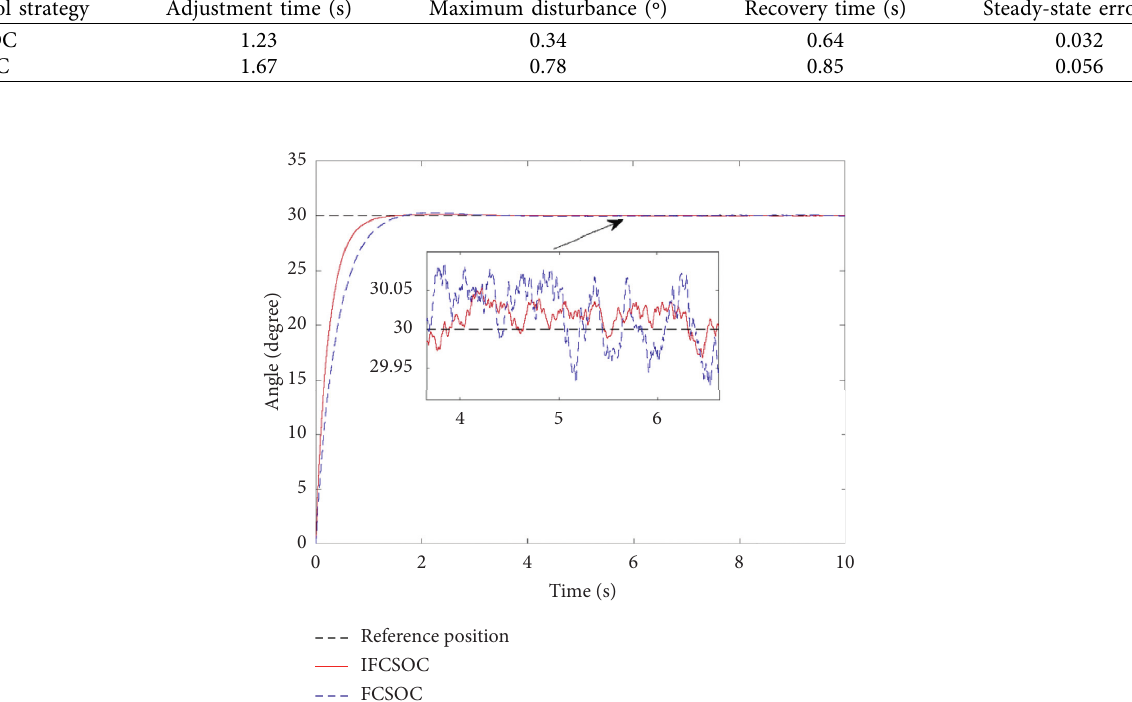
Figure 5: Step simulation with load rapidly changing